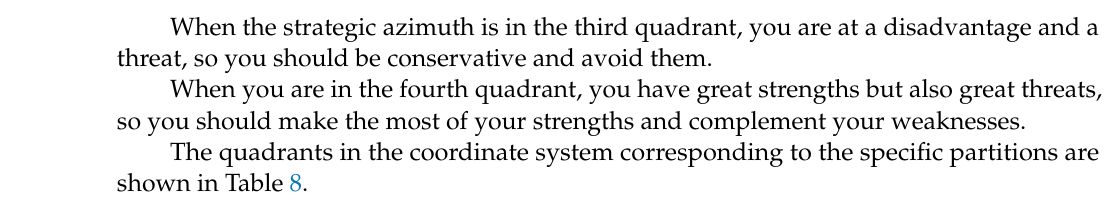
Table 8. Coordinate system and quadrant partitioning of the SWOT-AHP